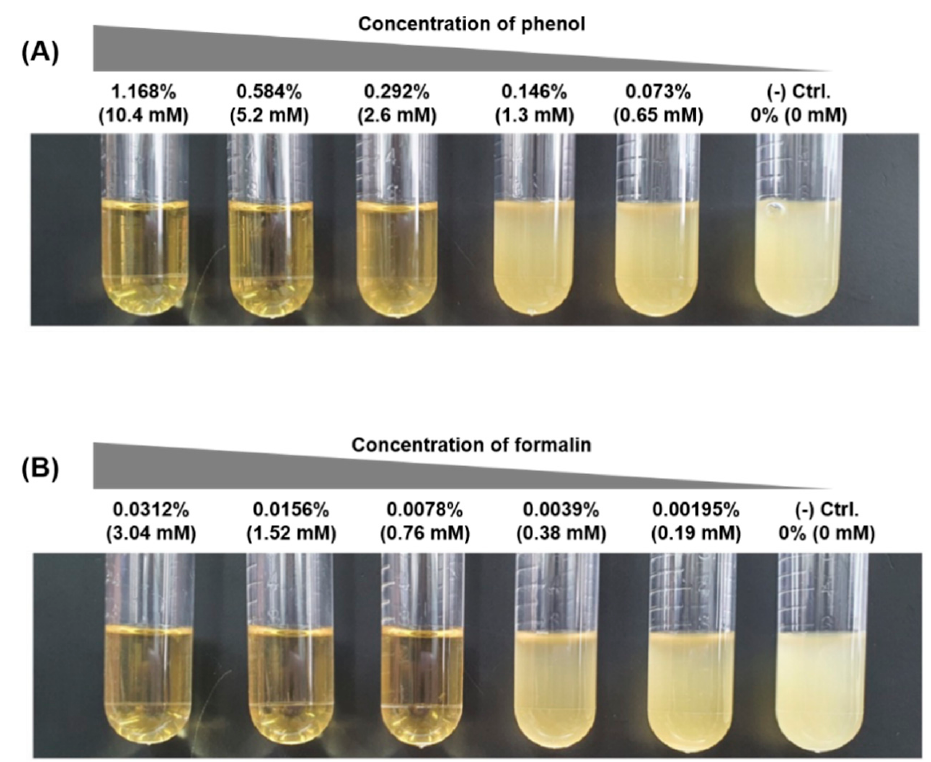
Figure 1. Identification of the sub-inhibitory concentration (sub-IC) for ( A ) phenol and ( B ) formalin. Cells were grown in 3 mL of Brain Heart Infusion (BHI) medium with the indicated percentages of phenol and formalin, respectively. The image was taken after 24 h of incubation at 27 °C.